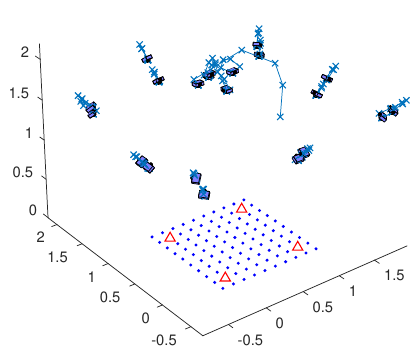
Figure 5: Evolution of the 3D camera network and object